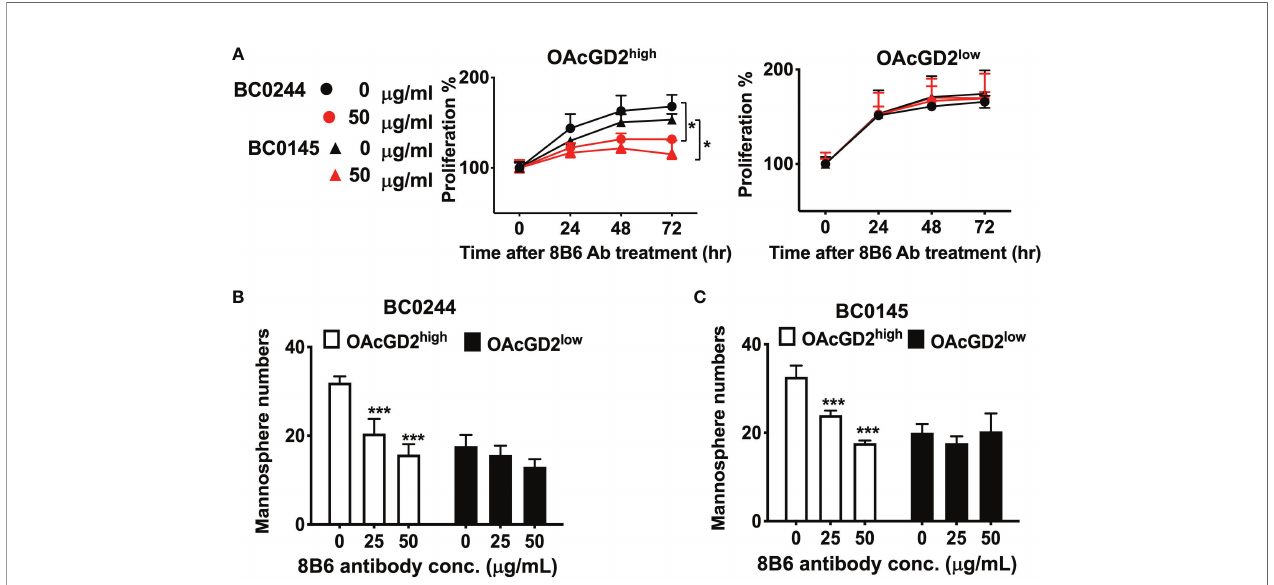
FIGURE 3 | Anti-OAcGD2 mAb8B6 inhibits mammosphere formation and proliferation of PDX cells. (A) OAcGD2 high ALDH + BC0244, OAcGD2 high CD44 + CD24 − BC0145 cells, OAcGD2 low ALDH + BC0244, and OAcGD2 low CD44 + CD24 − BC0145 cells were sorted and treated for 72 h with the indicated concentrations of mAb8B6. Cell proliferation was assessed by the AlamarBlue assay. Optical density was recorded at 570 nm and was expressed as proliferation % normalized to time 0 hr. (B) OAcGD2 low ALDH + and OAcGD2 low ALDH + BC0244 cells and (C) OAcGD2 low CD44 + CD24 − and OAcGD2 low CD44 + CD24 − BC0145 cells were sorted and plated at 1 × 10 3 /well in 96-well ultra-low attachment plates containing mammosphere growth medium. Cells were incubated for 7 days with the indicated concentrations of mAb8B6, and the number of mammosphere was counted under a light microscope. The data are presented as the mean ± SD of three independent experiments, each in triplicate. *** p < 0.001 compared to cells without 8B6 treatment. * p < 0.05 by Student ’ s